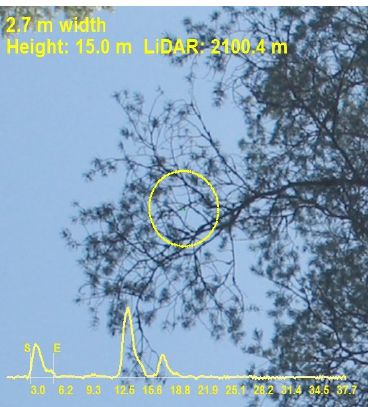
Figure 3. Relative footprint silhouette was extracted in images for detached branches inside a 1/e 2 footprint image that was binarized Leica ALS60 pulse with a 256-sample waveform, transmitted from a height of 2100 m. The pine branch is 15 m above ground and is the first target intersected by the pulse.